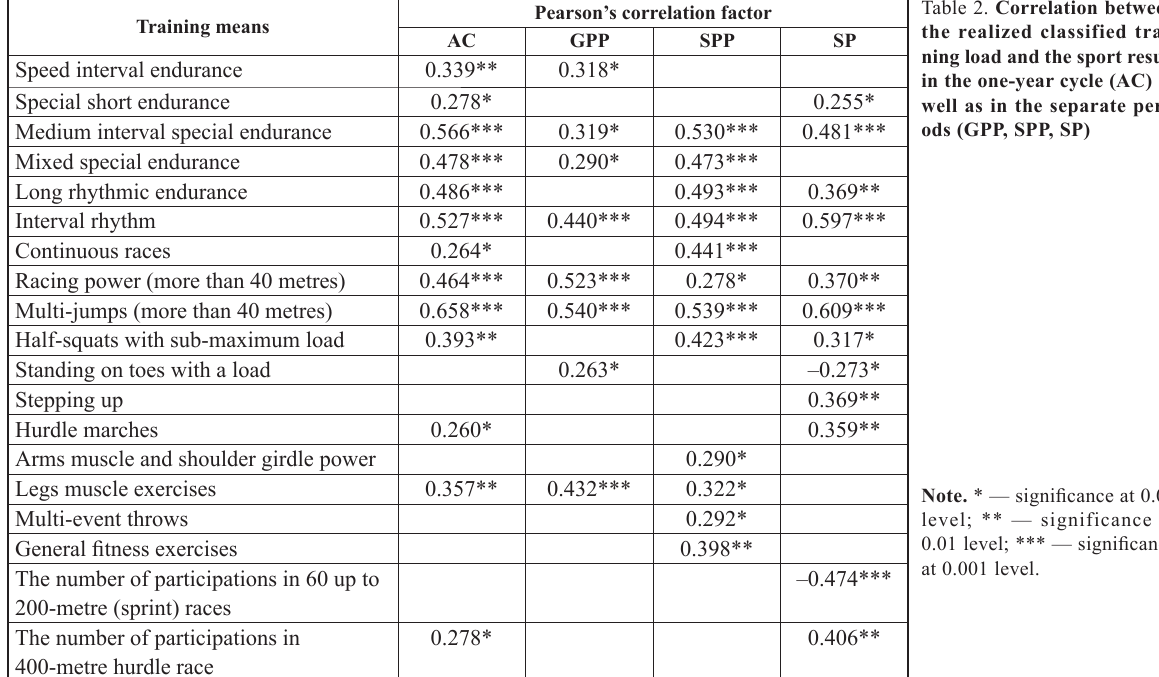
Table 2. Correlation between the realized classified trai- ning load and the sport result in the one-year cycle (AC) as well as in the separate peri- ods (GPP, SPP,